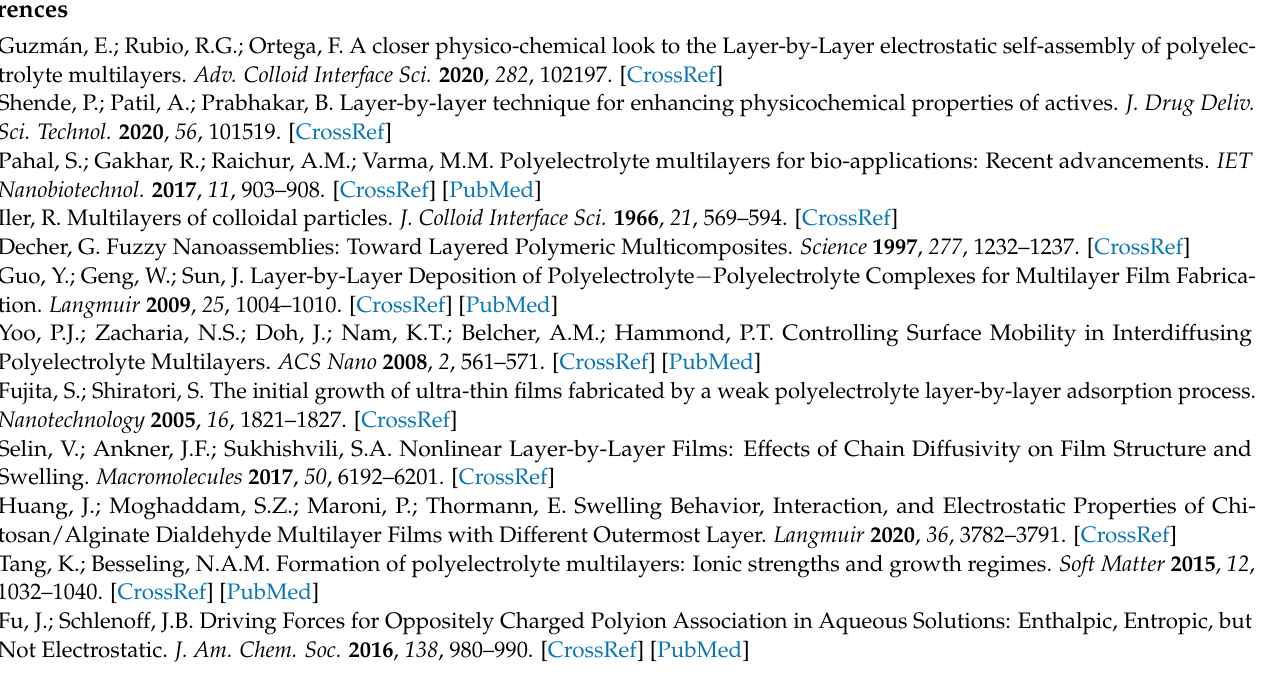
AAm, Figure S2: 1 H NMR spectrum of C1H recorded in D 2 O, Figure S3: 1 H NMR (nuclear magnetic resonance) spectrum of C2H recorded in D 2 O, Figure S4: 1 H NMR spectrum of CAm recorded in D 2 O, Figure S5: 1 H NMR spectrum of AH recorded in D 2 O, Figure S6: 1 H NMR spectrum of AAm recorded in D2O/DMSO-d6 (1:3 v/v ), Figure S7: The topography and cross sections of silicon